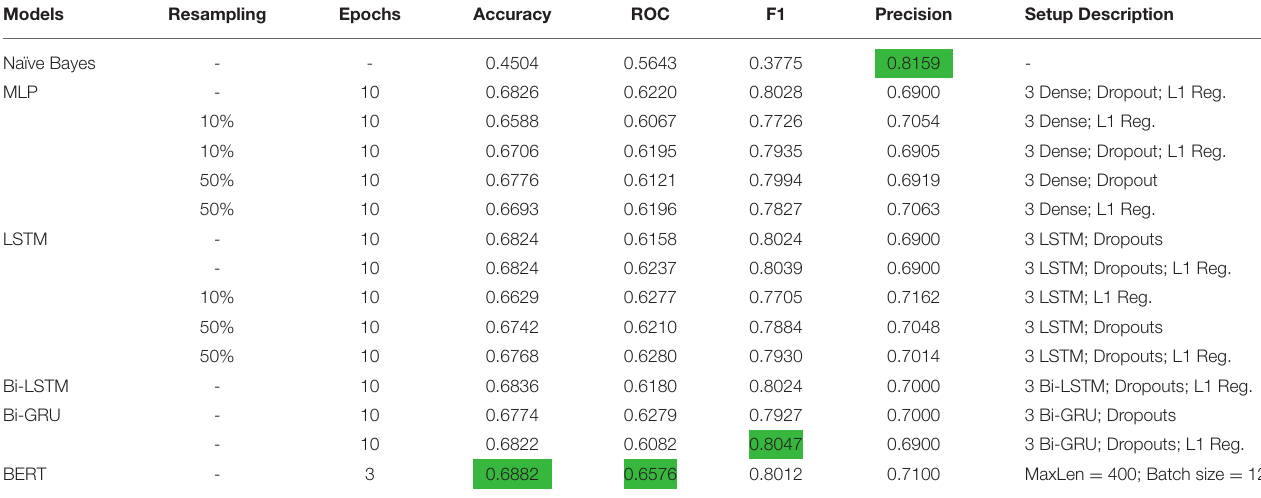
TABLE 6 | Classification performance on predicting FDV “ADVO breach” offense types (best results are highlighted in green). Models Naïve Bayes